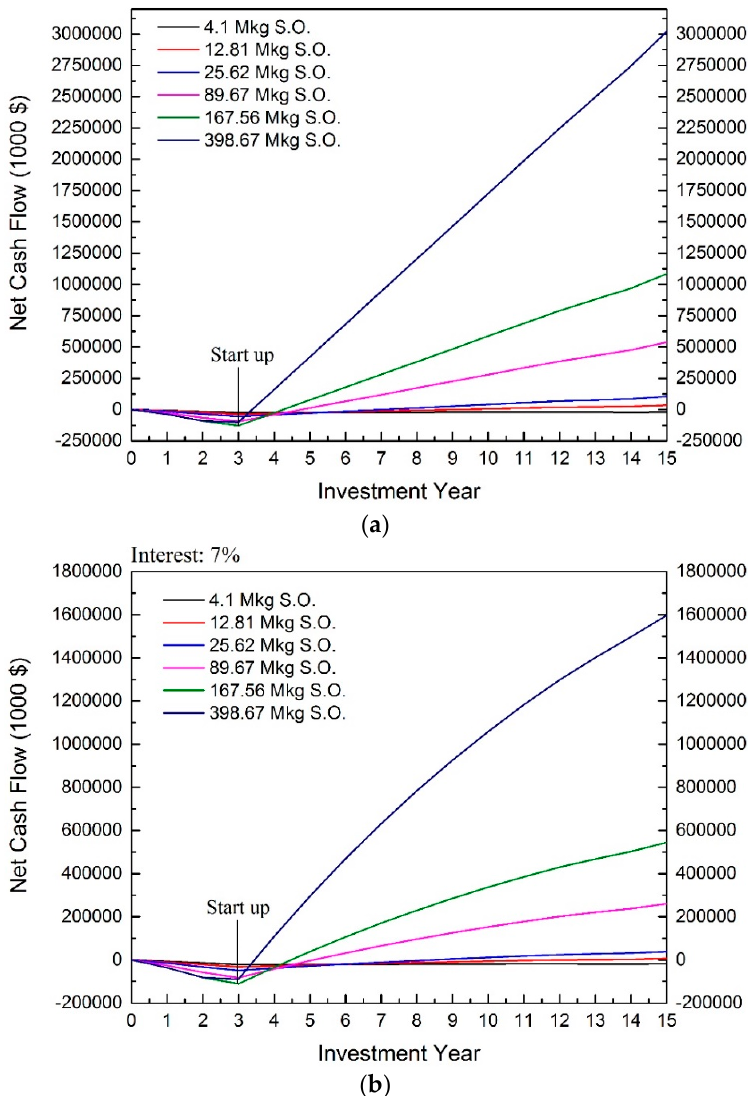
Figure 2. Cash flow of extruding-expelling process. ( a ) Interest rate is not considered; ( b ) 7% interest rate included. (S.O. indicates the annual soybean oil production).